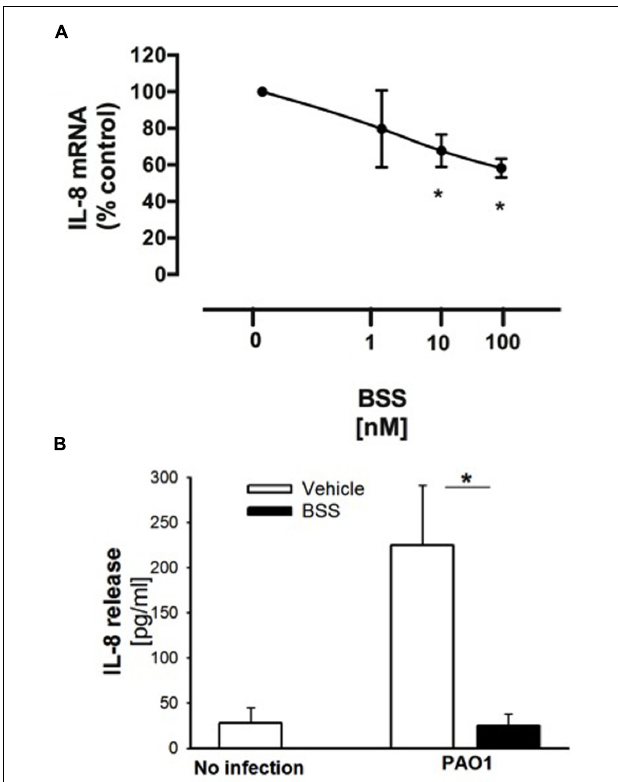
FIGURE 4 | Effect of BSS on PAO1-stimulated IL-8 expression in IB3-1 cells. (A) IB3-1 cells were treated with ranging doses (1–100 nM) of BBS for 16 h and infected with PAO1 for further 4 h. IL-8 mRNA expression was measured as indicated in the legend of Figure 2 . The results are expressed as the % of untreated cells. Data are mean ± SEM of three independent experiments performed in duplicate. (B) IB3-1 cells were treated with 100 nM BSS for 16 h and infected with PAO1 for further 4 h. IL-8 release in the supernatant was measured by ELISA assay. Representative experiment performed in